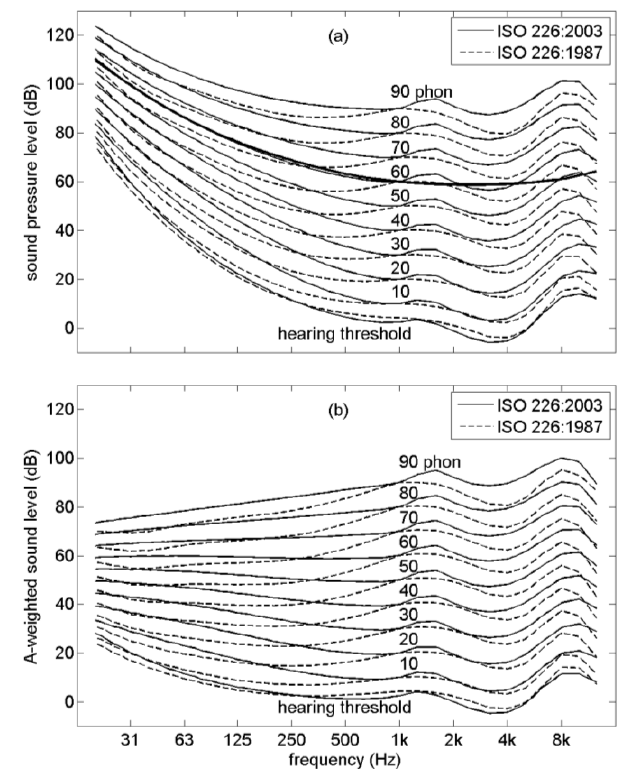
Figure 1. Equal-loudness contours and hearing threshold of pure tones, as a function of frequency and sound pressure level (a) and A-weighted sound level (b) , according to ISO 226:2003 and ISO 226:1987. The thick line represents the A-weighting curve.